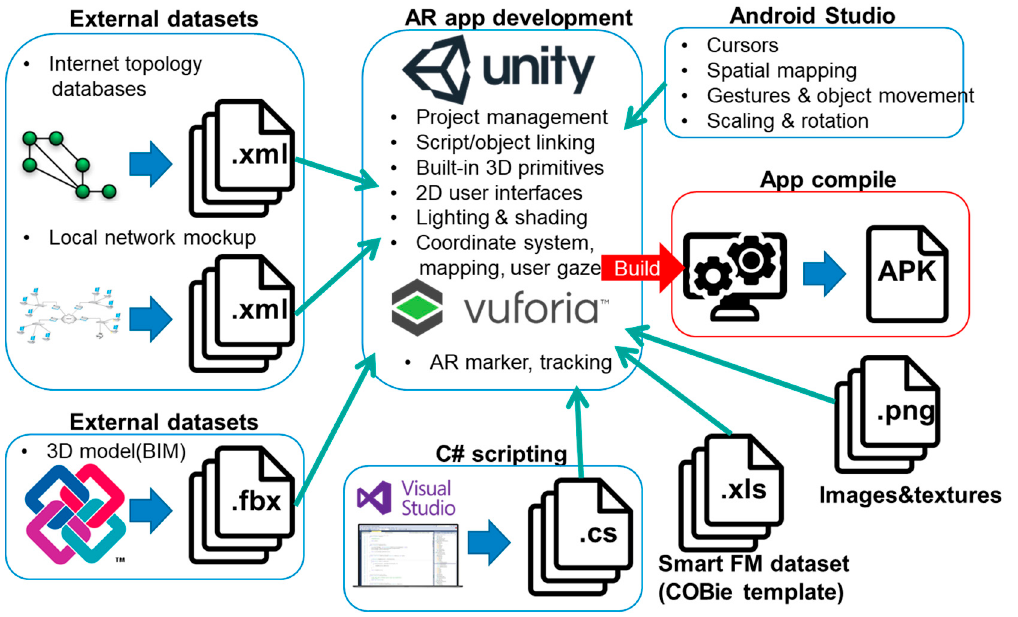
Figure 10. Development process for AR-based smart FMSs.